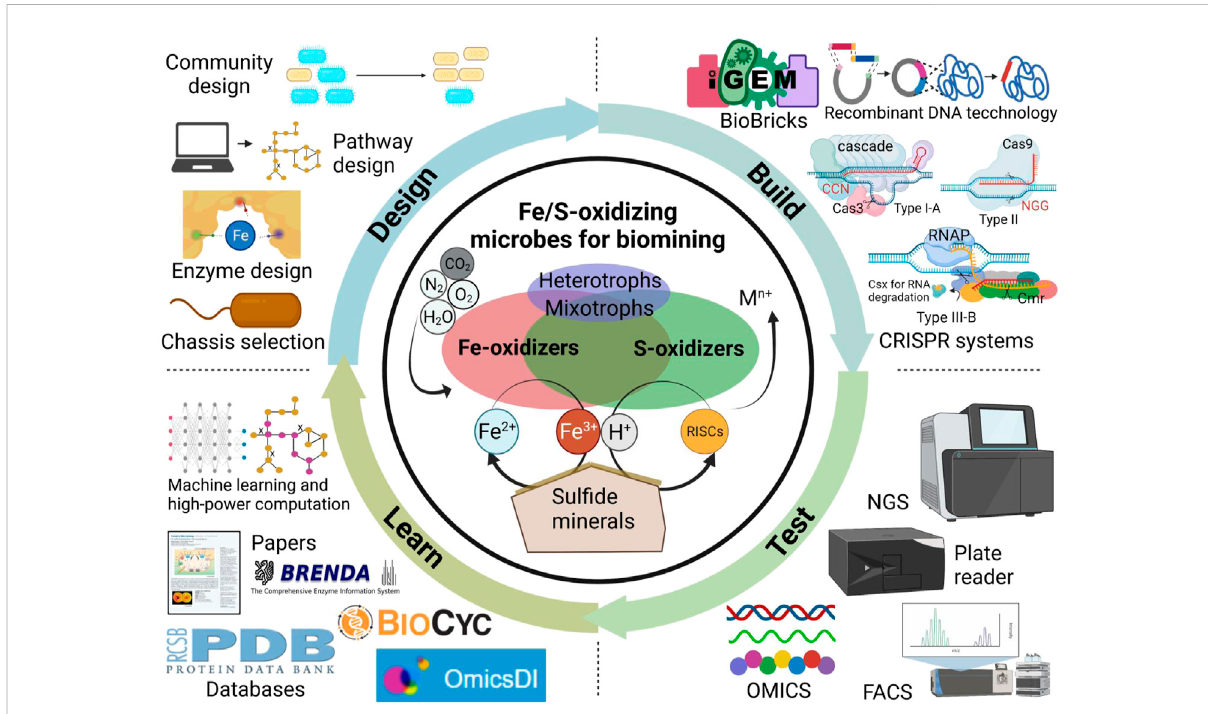
FIGURE 1 Harnessing synthetic biology for sustainable biomining with Fe/S-oxidizing microbes. Technology advances accelerate the